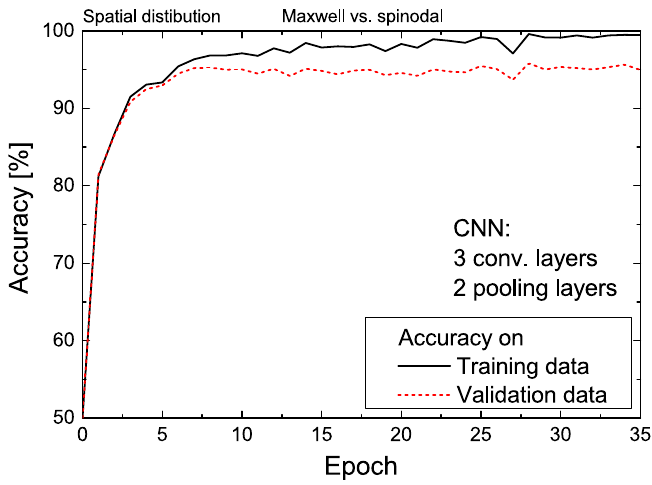
Figure 3 . Training and validation accuracy for the Convolutional Neural Network (CNN) with coordinate-space input. After about 5 epochs the network starts over-(cid:12)tting. Nevertheless, a good accuracy of about 95% can be achieved without optimization of the network